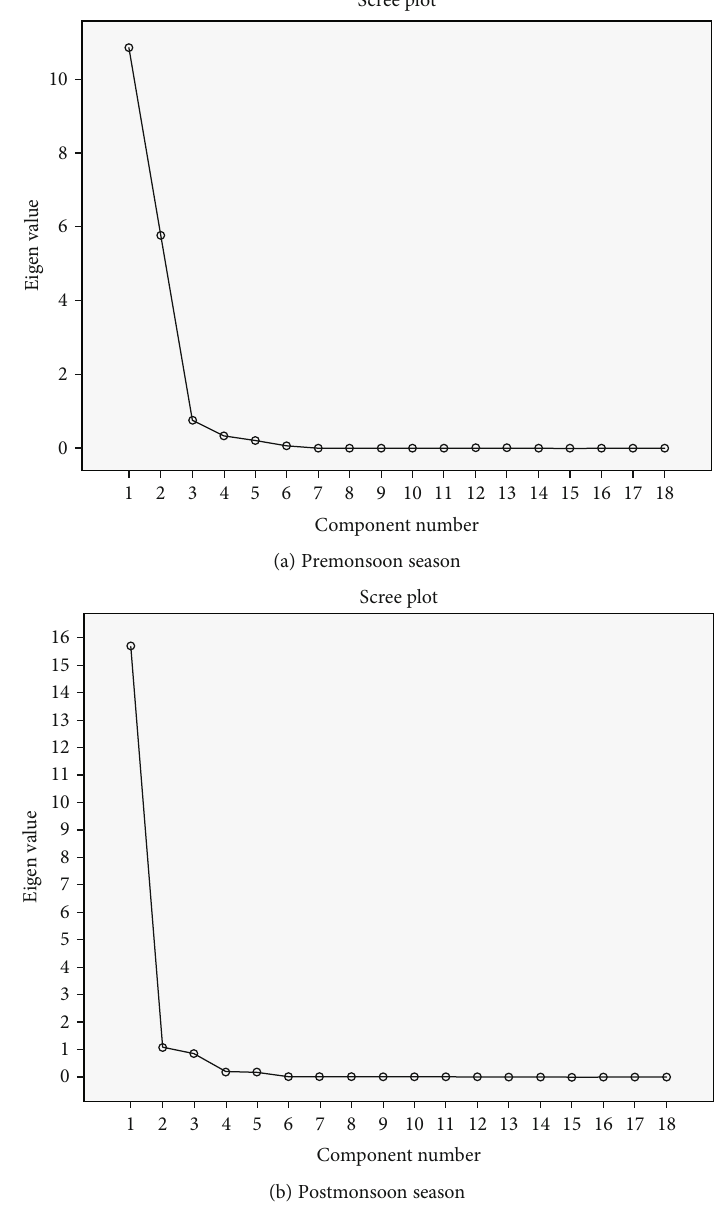
Figure 4: (a, b) Scree plot of the eigenvalues for principal